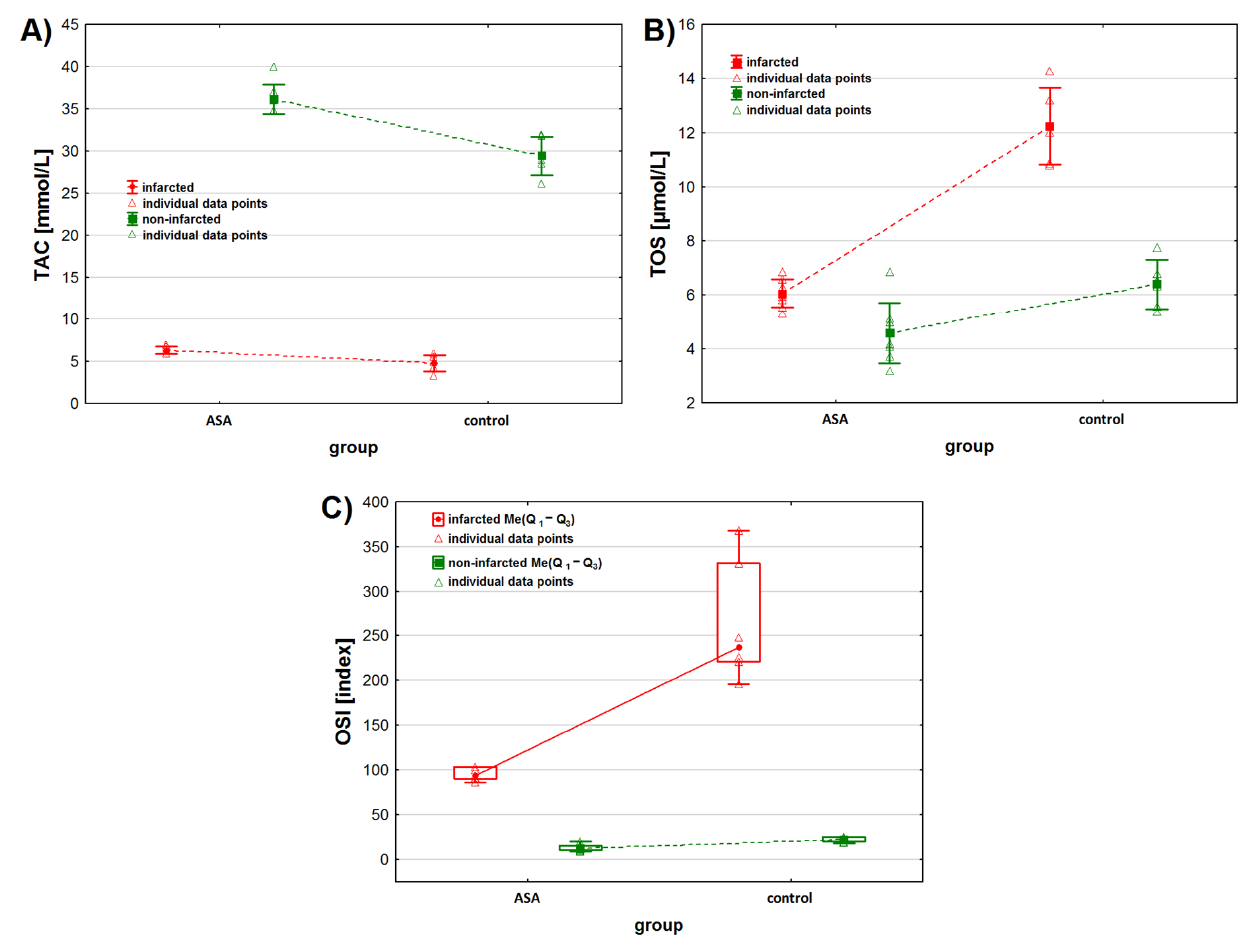
Figure 1. Oxidative stress markers levels in infarcted and the non-infarcted tissues collected from the left ventricle of the heart of pigs ( n = 13) subjected to a myocardial ischemia-reperfusion protocol assessing the effectiveness of intracoronary administered acetylsalicylic acid (ASA): ( A ) total antioxidant capacity (TAC) [mmol/L], ( B ) total oxidative status (TOS) [µmol/L] and ( C ) oxidative stress index (OSI) [index]. Results in ( A ) and ( B ) are presented as mean ± 95% confidence interval and in ( C ) as median (lower, upper quartile) and minimum and maximum. In all figures, triangular markers represent the raw data. For the reader’s convenience, the points are connected with dashed lines. Table 3. Contrast analysis of oxidative stress markers in infarcted and the non-infarcted tissues col- lected from the left ventricle of the heart of pigs ( n = 13) subjected to a myocardial ischemia-reper- fusion protocol assessing the effectiveness of intracoronary administered acetylsalicylic acid (ASA).